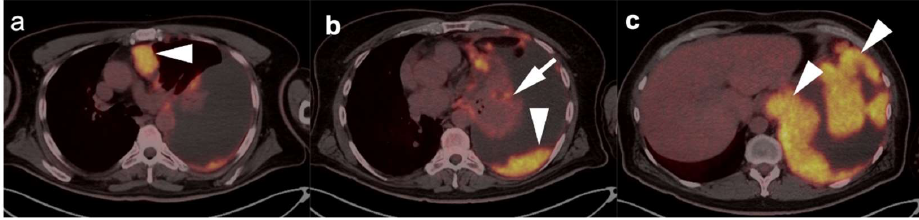
Figure 14. Malignant pleural mesothelioma ( a – c ). Bulky hypermetabolic soft tissue within the pleural space of the left lung ( white arrowheads ), associated with a large left pleural effusion and atelectatic collapse of the left lower lobe. Small focal areas of metabolic activity in the collapsed left lower lobe could be metastatic foci versus areas of superimposed inflammatory change ( white arrow ).